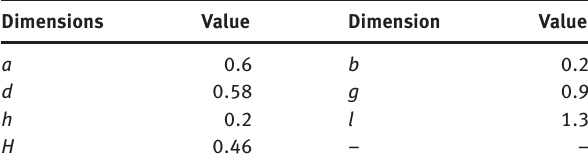
Figure 4: Periodic unit cell of weave composites.